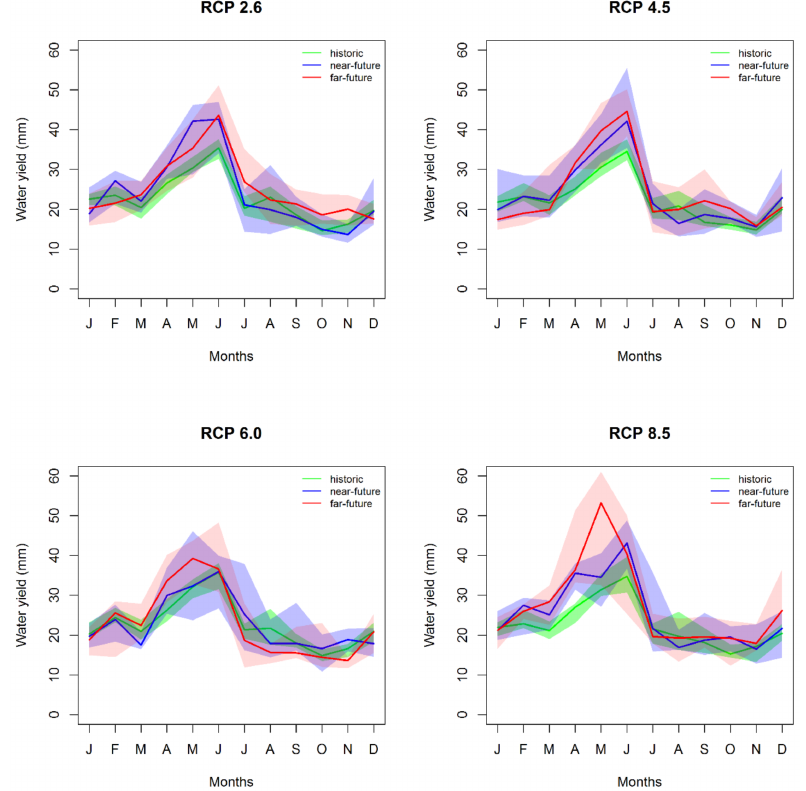
Figure 8. Monthly ensemble median and quartile of downscaled monthly water yield for historic and future projections in Goodwater Creek Experimental Watershed. The median is represented by the solid line with Q1 represented by the lower bound of the shaded region and Q3 represented by the upper bound of the shaded